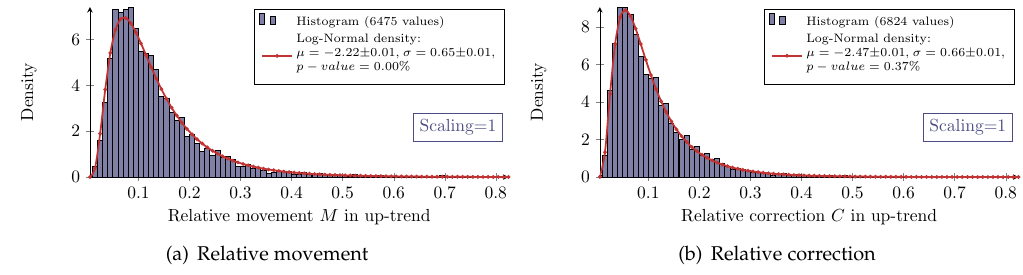
Figure 10. Measured and log-normal fit density of the relative movement (a) and relative correction (b) in an up-trend with scaling one for S&P100 stocks. The data are visualized via histogram from zero to one with a bin size of 0.01.